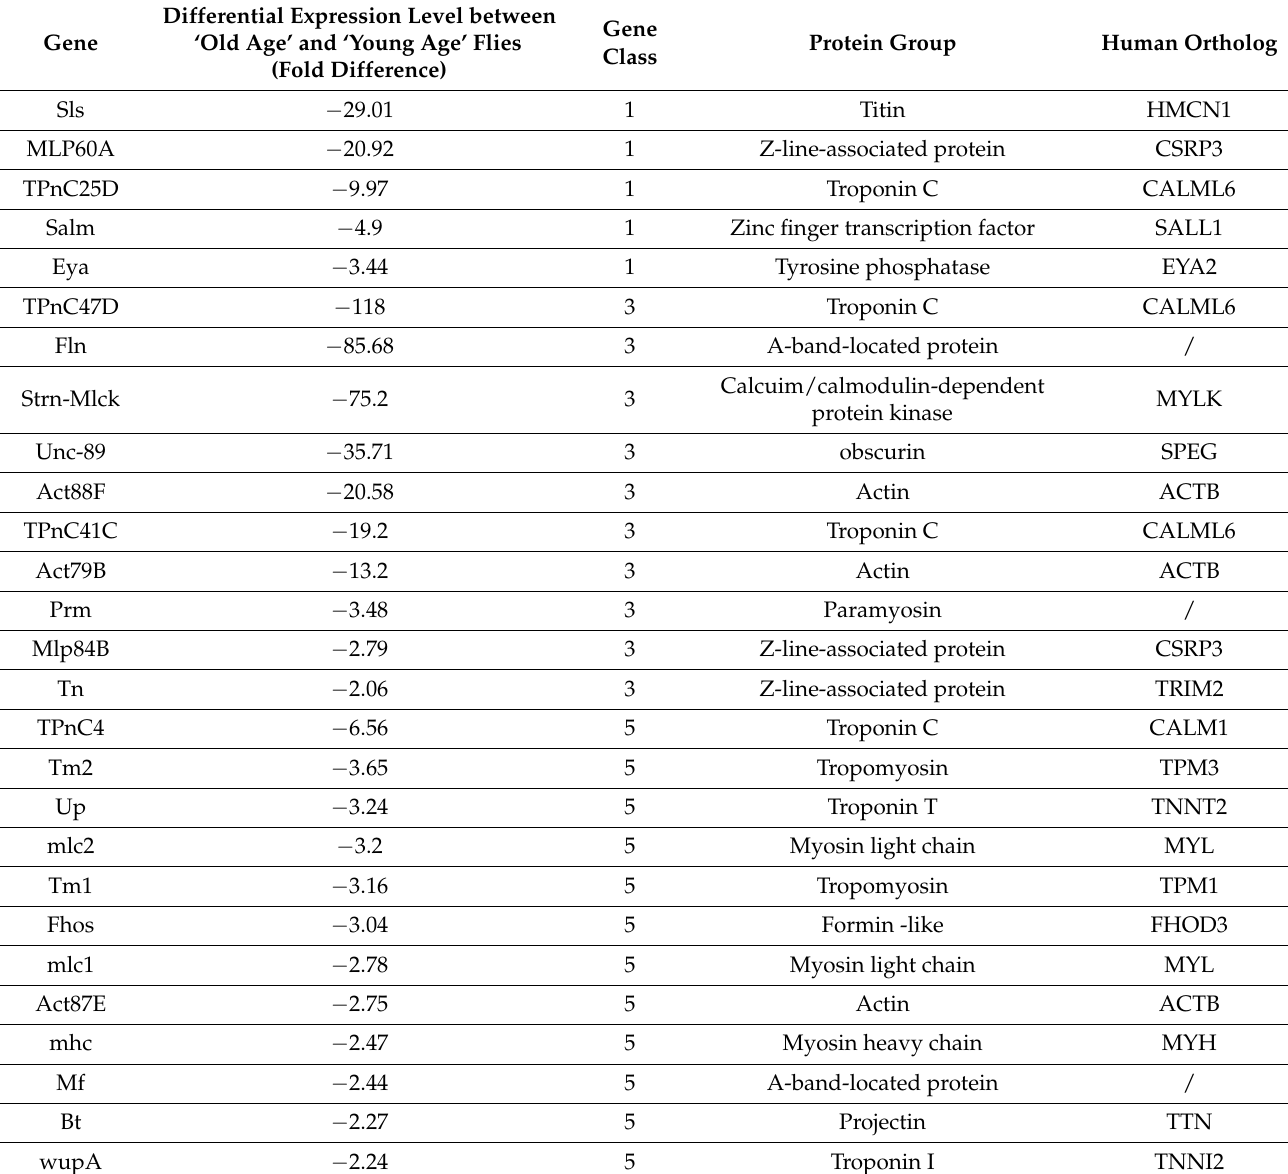
Table 2. Sample of genes that belong to the GO-terms “Muscle structure development” and “actin cytoskeleton organization”. Fold change shown is old age flies relative to young age